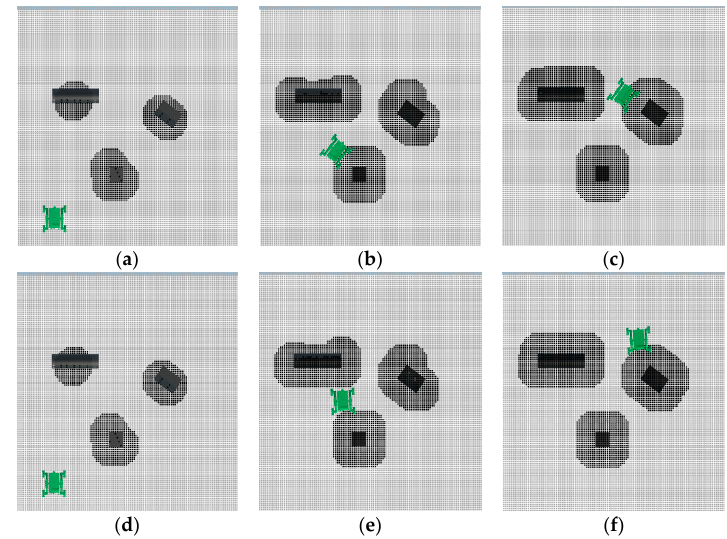
Figure 35. Robot simulation processes on obstacle avoidance ground: ( a–c ) simulation process in the first motion mode; ( d–f ) simulation process in the second motion mode. Sensors 2019 , 19 , x FOR PEER REVIEW